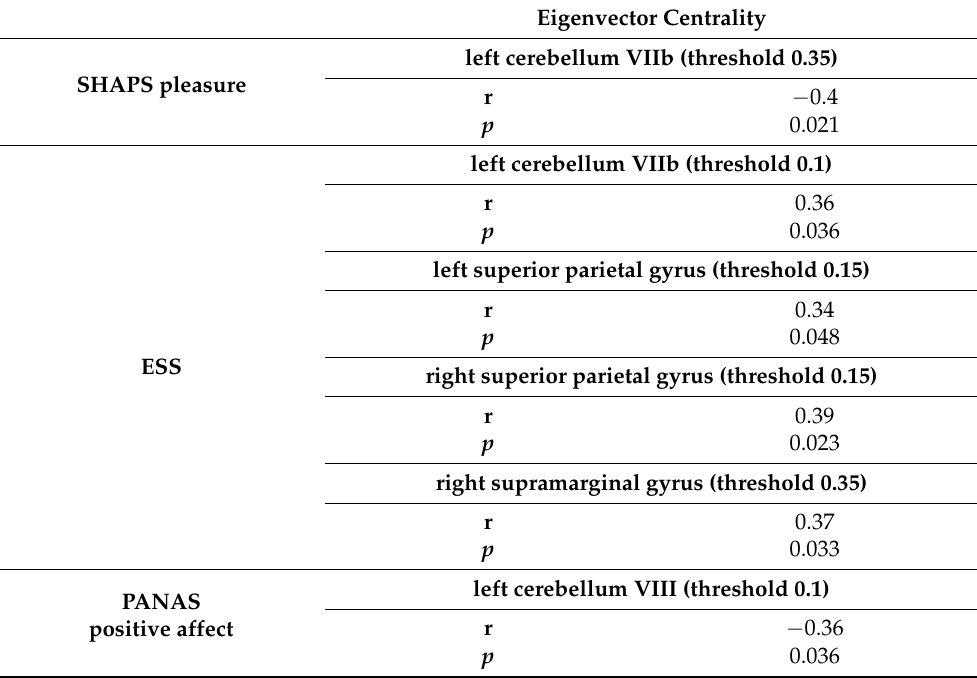
Table 3. Significant correlations between significant between-session differences in eigenvector centrality and psychological